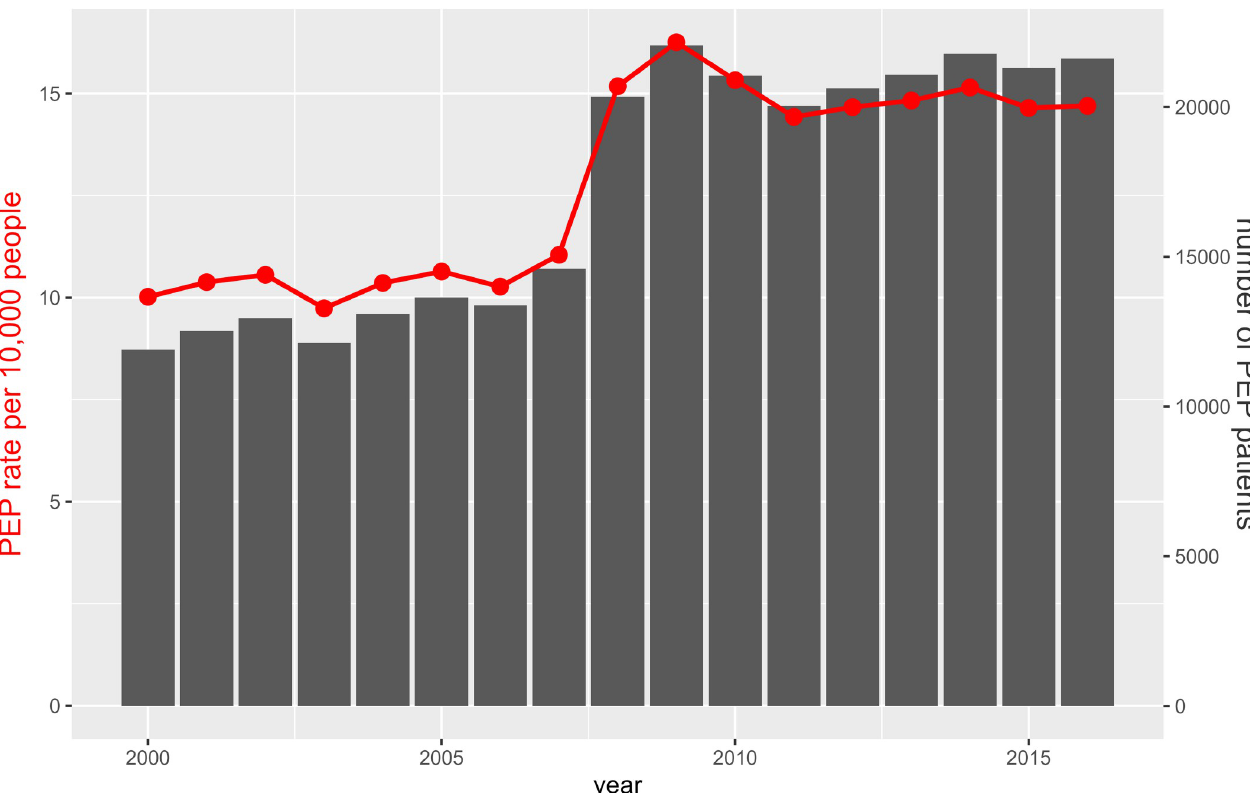
Fig 1. Observed number and rates of PEP in Cambodia from 2000 to 2016. Red curves represent rates per 10,000 people and histogram bars represent absolute numbers.